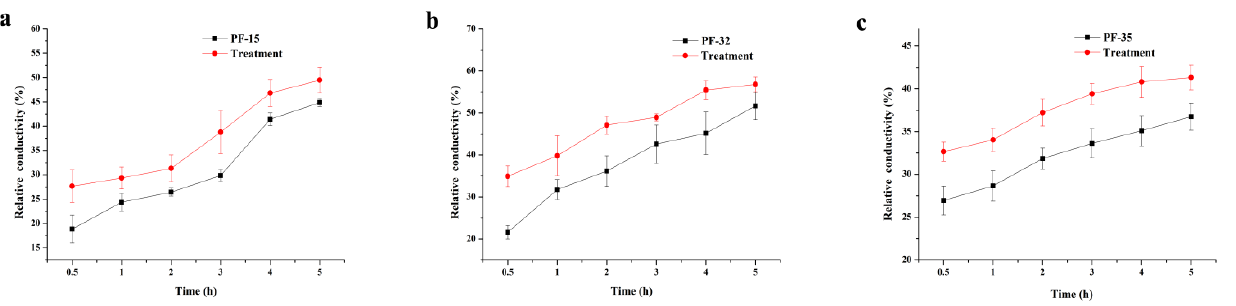
Figure 2. Effect of wood tar on the relative conductivity of the three strains ( a ) PF-15, ( b ) PF-32, and ( c ) PF-35. Bars denote the stand errors of three experiments.